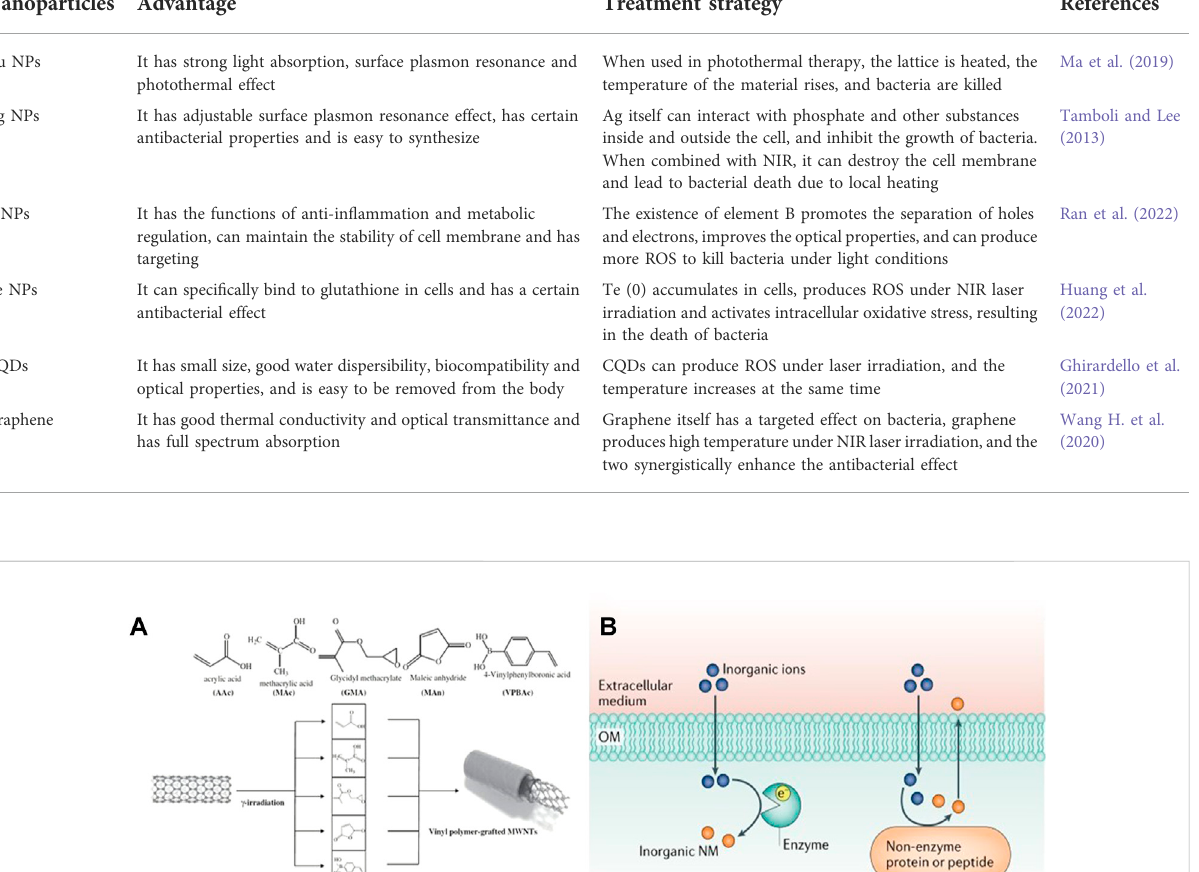
TABLE 2 Summary of inorganic nanomaterials for NIR photothermal